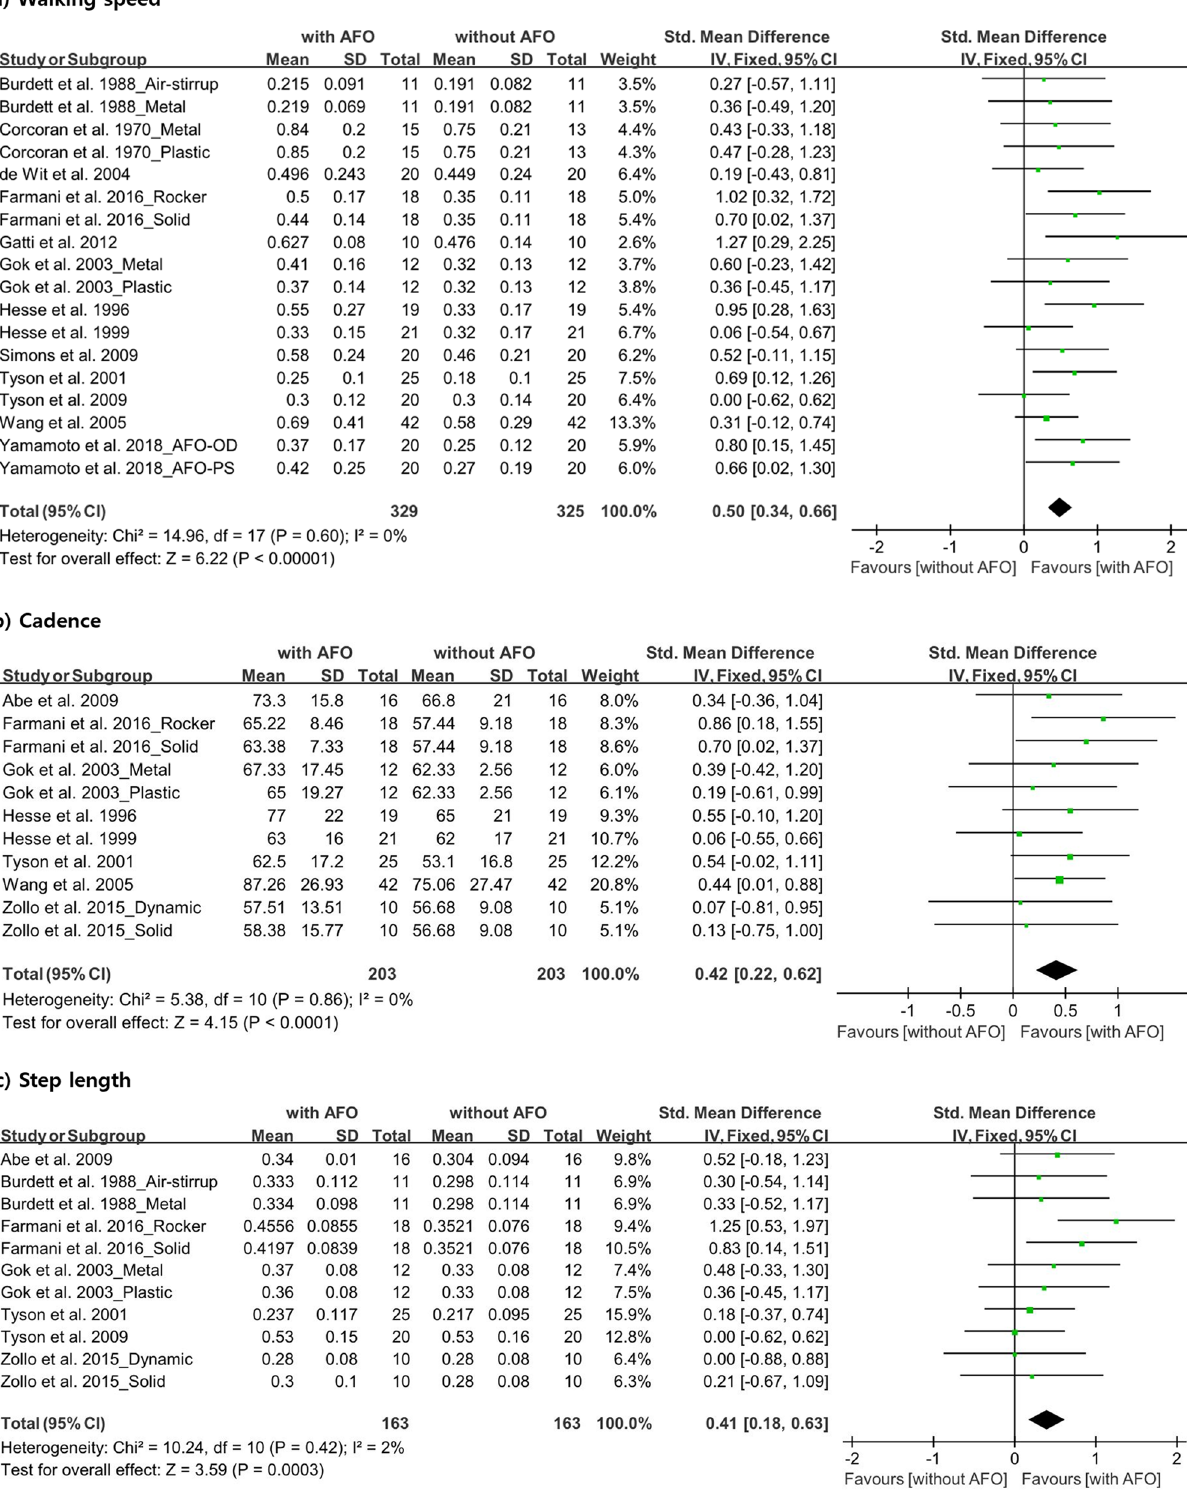
Figure 2. Forest plot showing the results of ( a ) walking speed, ( b ) cadence and ( c ) step length with or without ankle–foot orthosis